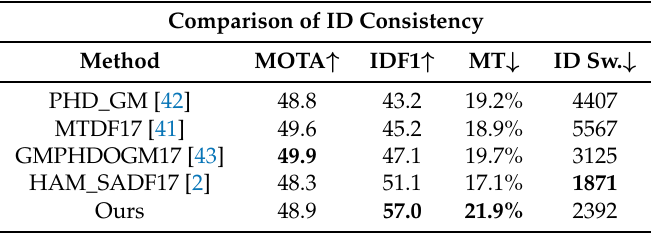
Table 2. Comparison of ID consistency with similar MOTA (FP and FN) in MOT17 benchmark